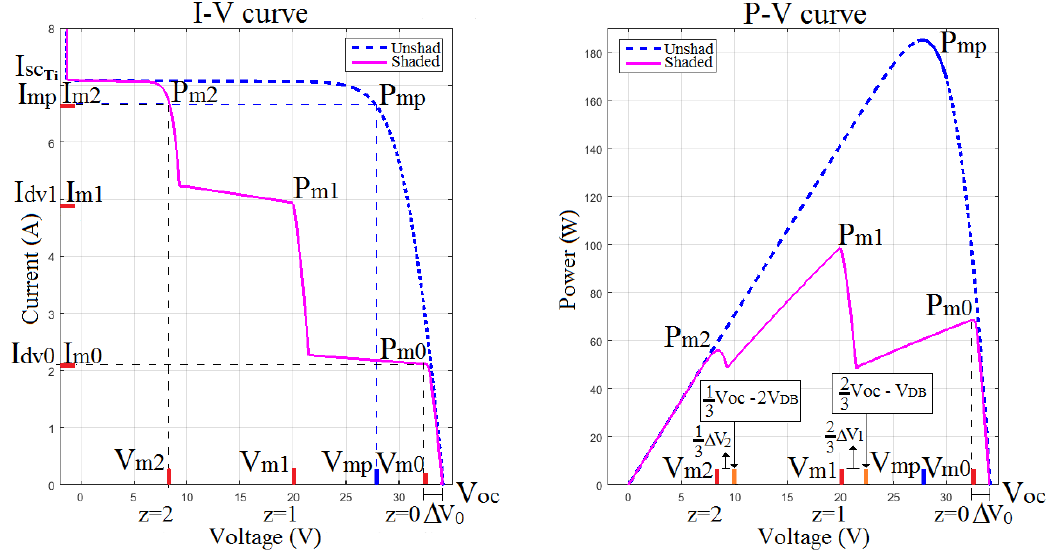
Figure 8. I–V and P–V curves for a partially shaded PV